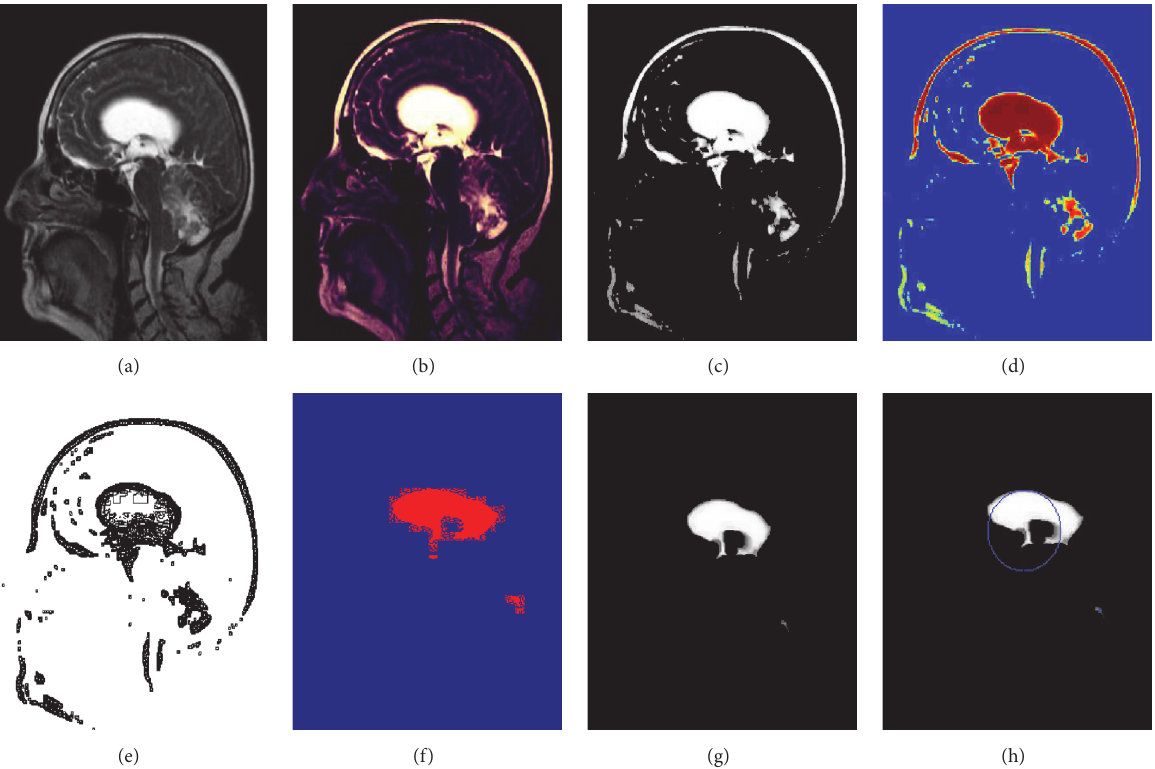
Figure 6: Experimental results of image 3. (a) Original image. (b) Enhanced image. (c) Skull-stripped image. (d) Wavelet decompose image. (e) Intense segmented image. (f) Dice overlap image. (g) Tumor region. (h) Area extracted tumor region.